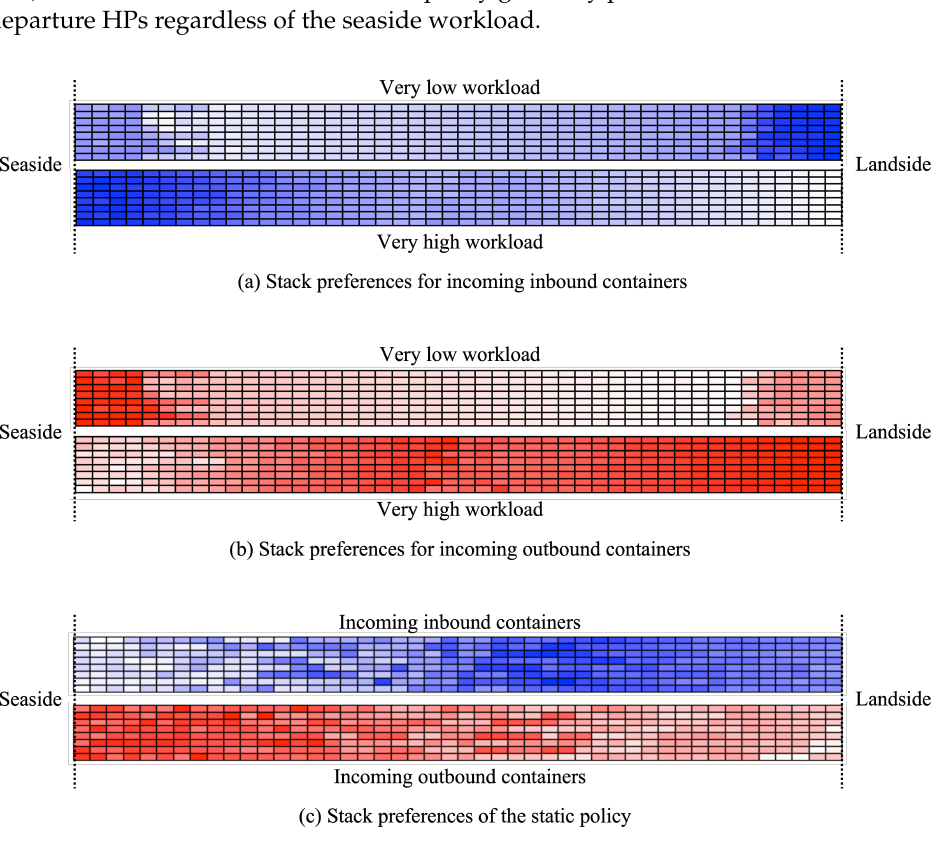
Figure 5. Comparison of the stack